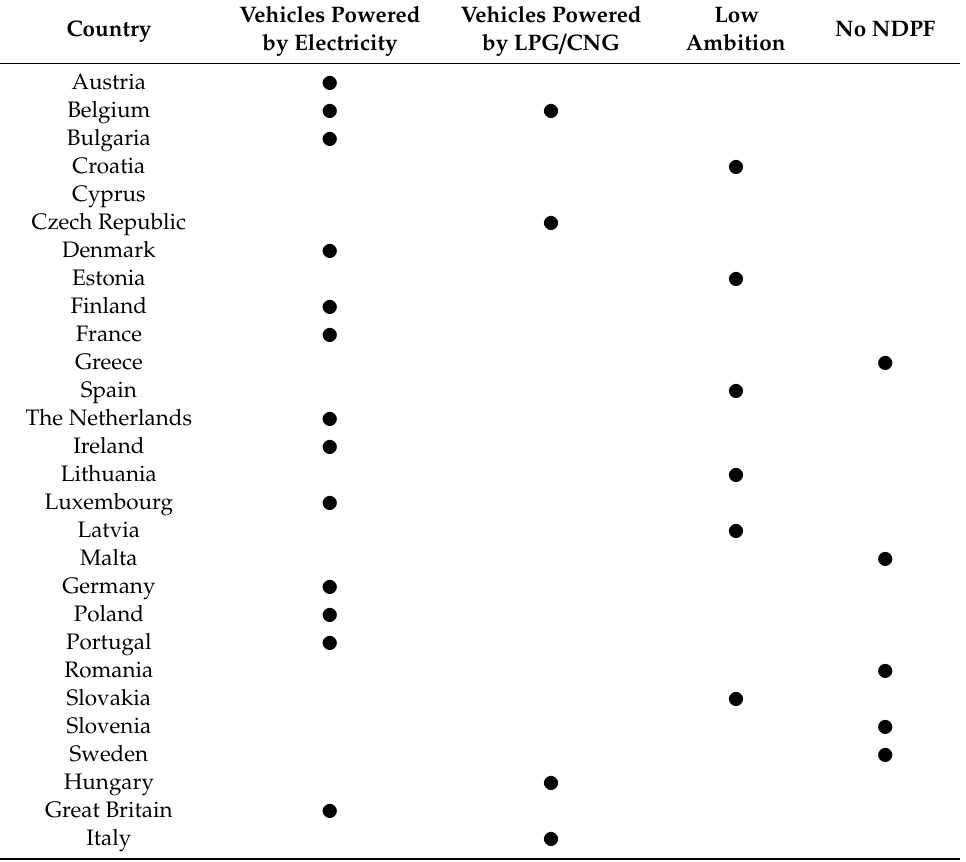
The (cid:8) symbol means attitude of European countries towards the development of individual alternative